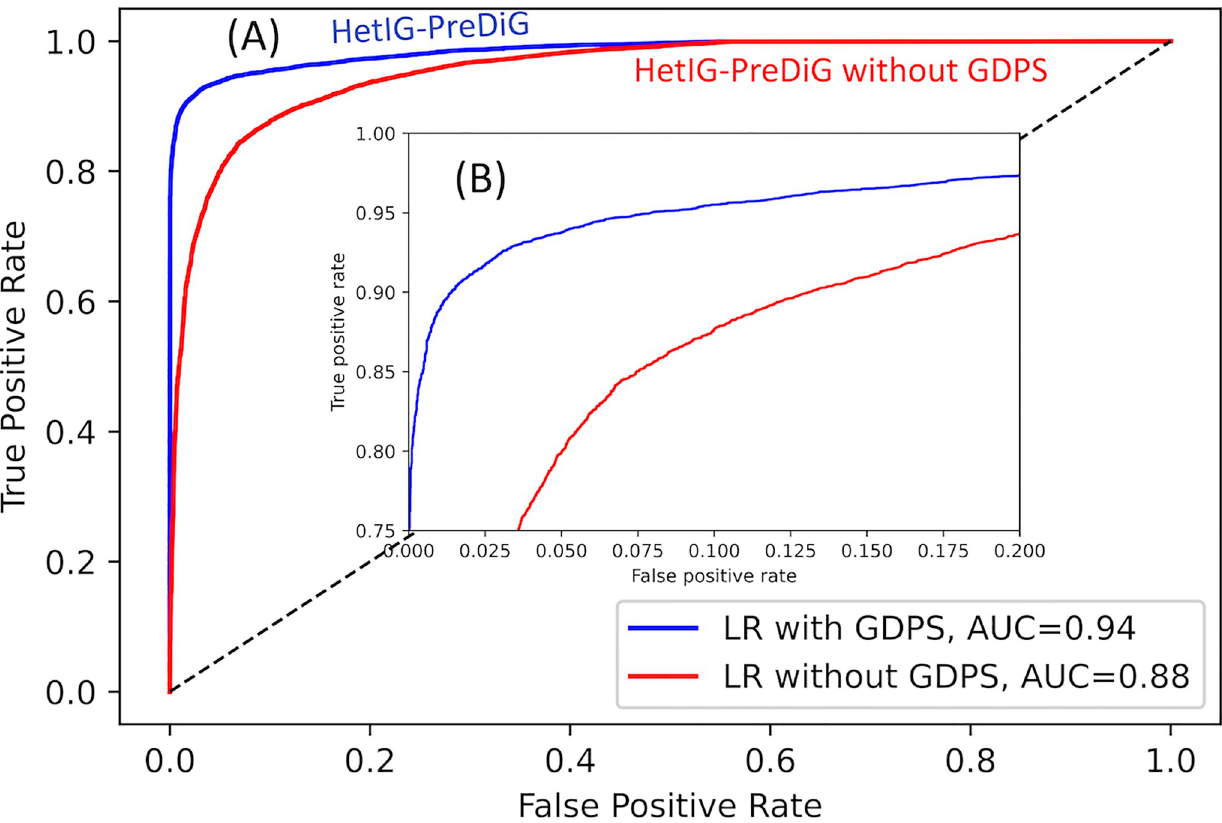
Fig 4. An ablation study. Demonstrating the effectiveness of using the developed Gene-Disease Prioritization Score (GDPS) in the developed HetIG-PreDiG model that incorporates a logistic regression (LR) classifier. (A) Receiver operating characteristic (ROC) curves of the developed model with (blue), and without (red) GDPS. The area under each ROC curve (AUC) is indicated. (B) A zoomed view of the top left corner of Fig 4A.